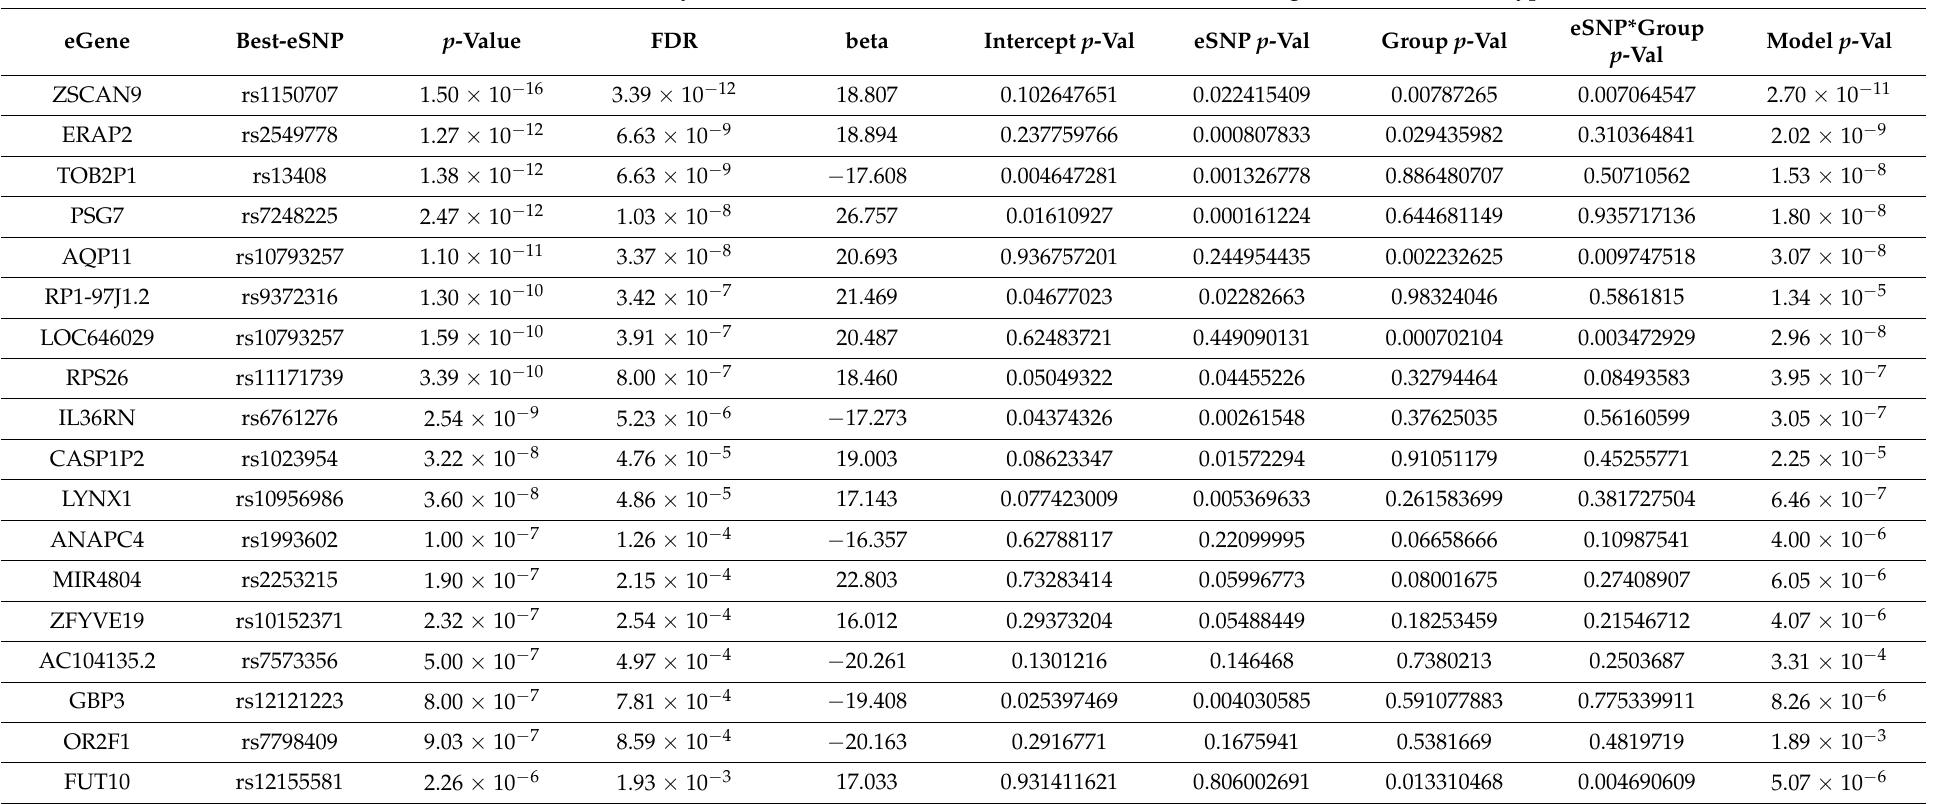
Table 4. Best-eSNP-eGene pairs for the MINUS DISEASE dataset showing the summary statistics from the eQTL analysis and the results of testing the significance of the interaction between genotype and disease on gene expression. The Best-eSNP, in this case, is defined as the most significant cis-eQTL associated with each eGene (smallest recorded q -value). Beta corresponds to the slope coefficient for the multivariate linear model and is an estimation of the eSNP effect size on gene expression variance. The table shows the test p -values for each coefficient of the linear model to test the effect of genotype and disease on gene expression and their interaction, as well as the model p -value. eGenes that presented a statistically significant interaction between eSNP genotype and disease status ( p -value ≤ 0.05) are highlighted in